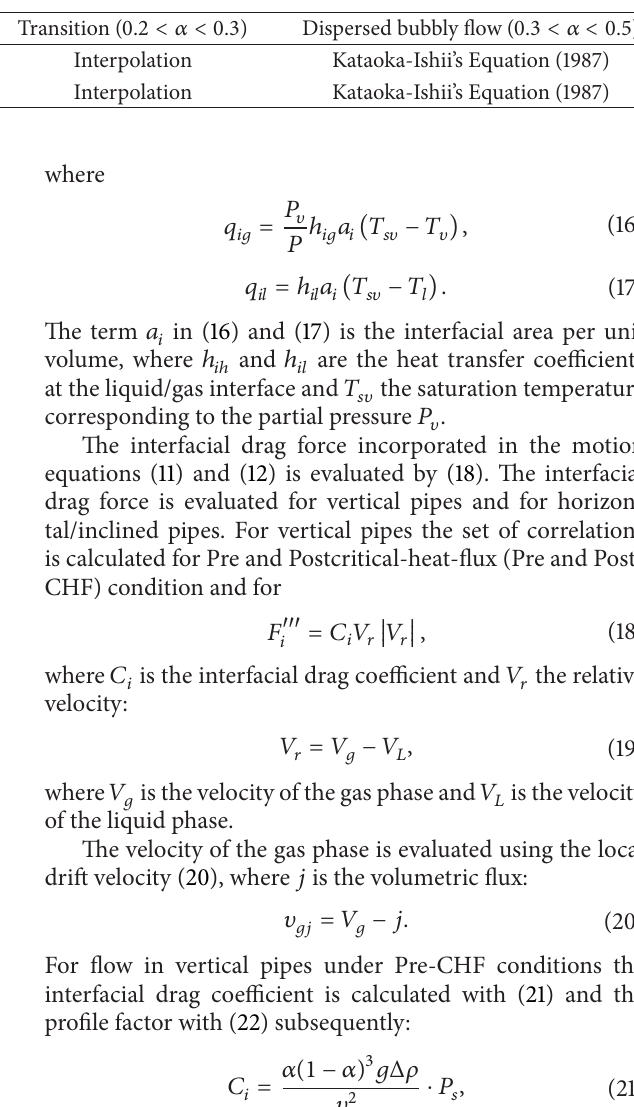
Table 3: Pre-CHF local drift velocity ( 𝑣 𝑔𝑗 ) and distribution coefficient ( 𝐶 𝑂